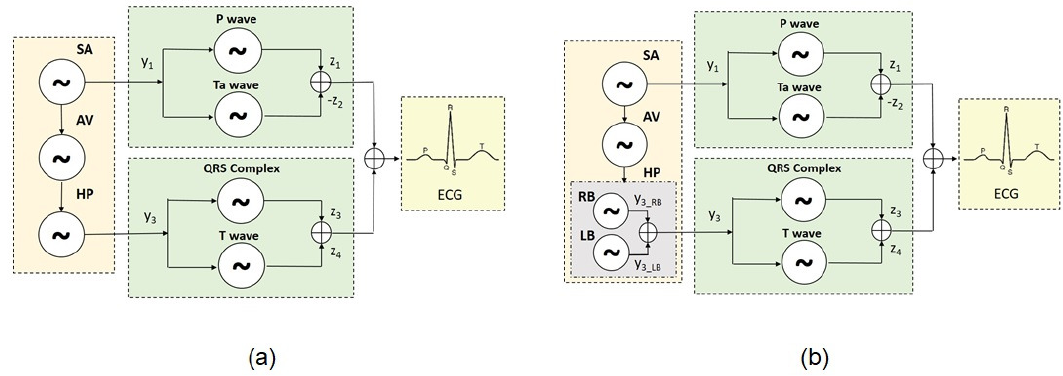
Figure 2. Heart mathematical models. ( a ) Ryzhii model [22], based on three oscillators; ( b ) modified model, based on four